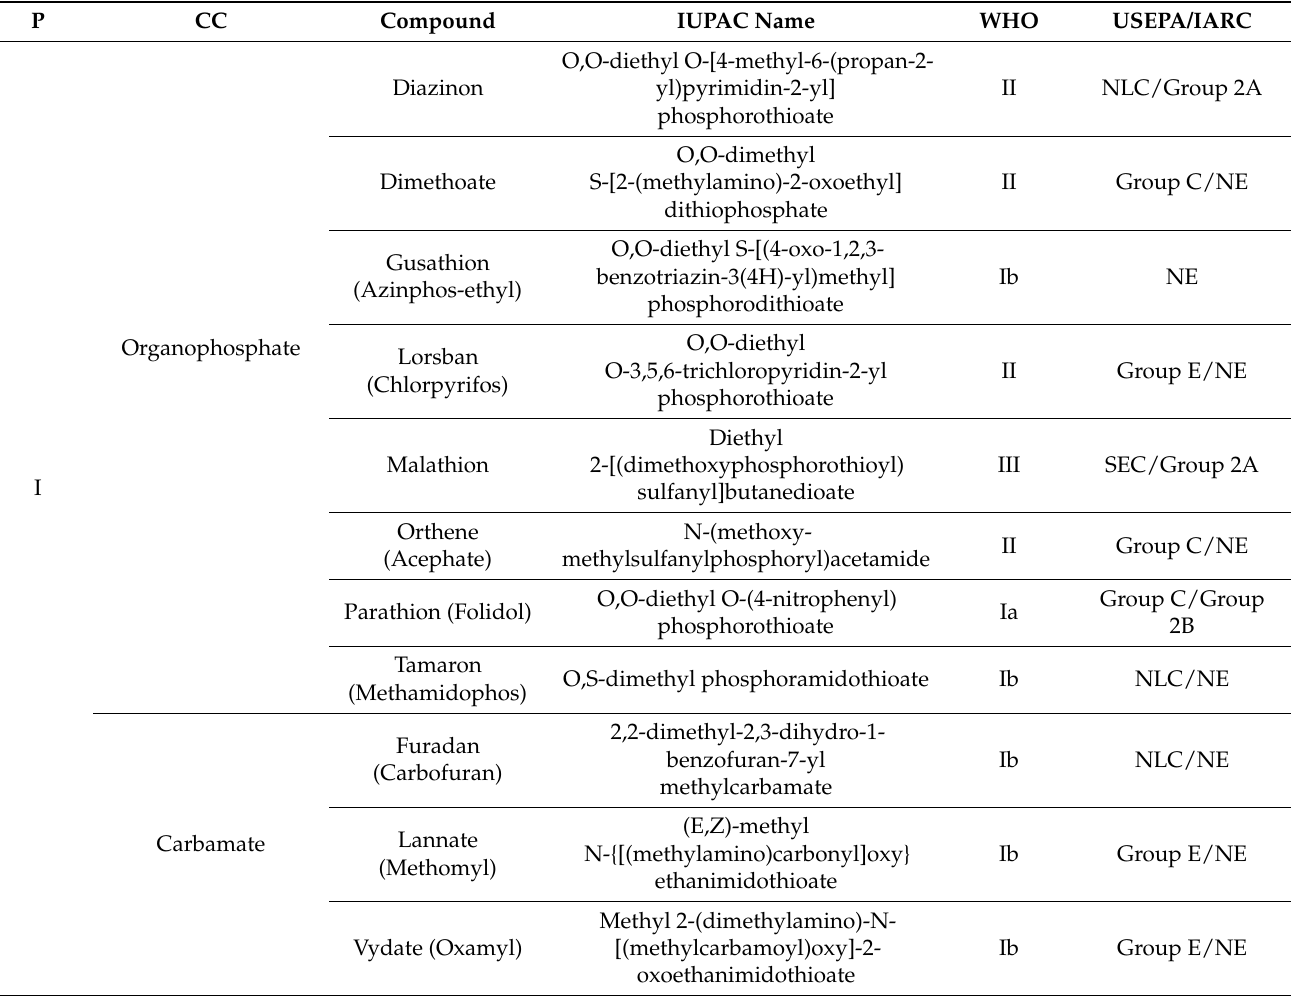
Table 2. List of the more frequent pesticides used by the exposed group and their hazard classification.